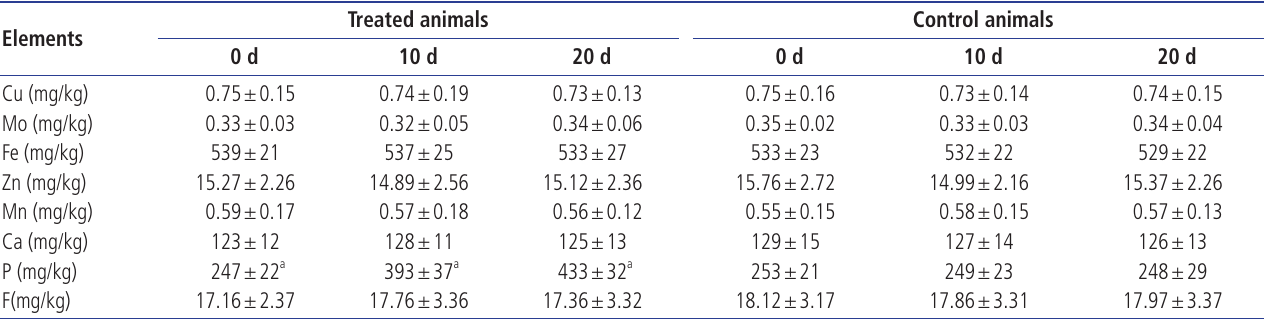
Table 7. Mineral element contents in blood in treatment and control groups Treated animals Control Elements